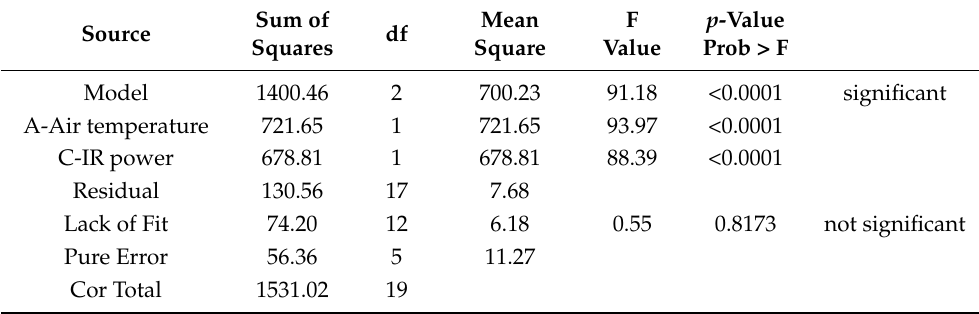
Table 11. Analysis of variance for AA response using